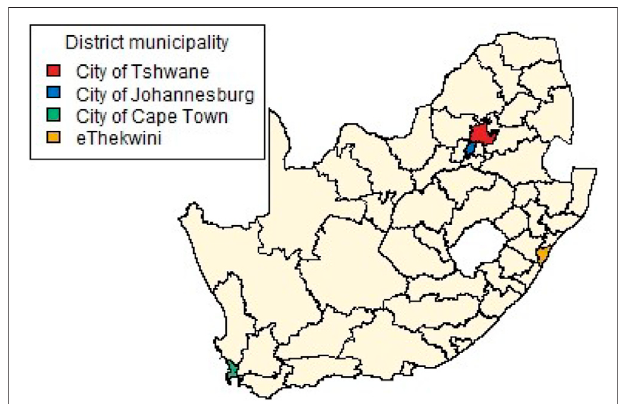
FIGURE 4 | South Africa ’ s district municipality boundaries and locations of four largest cities.